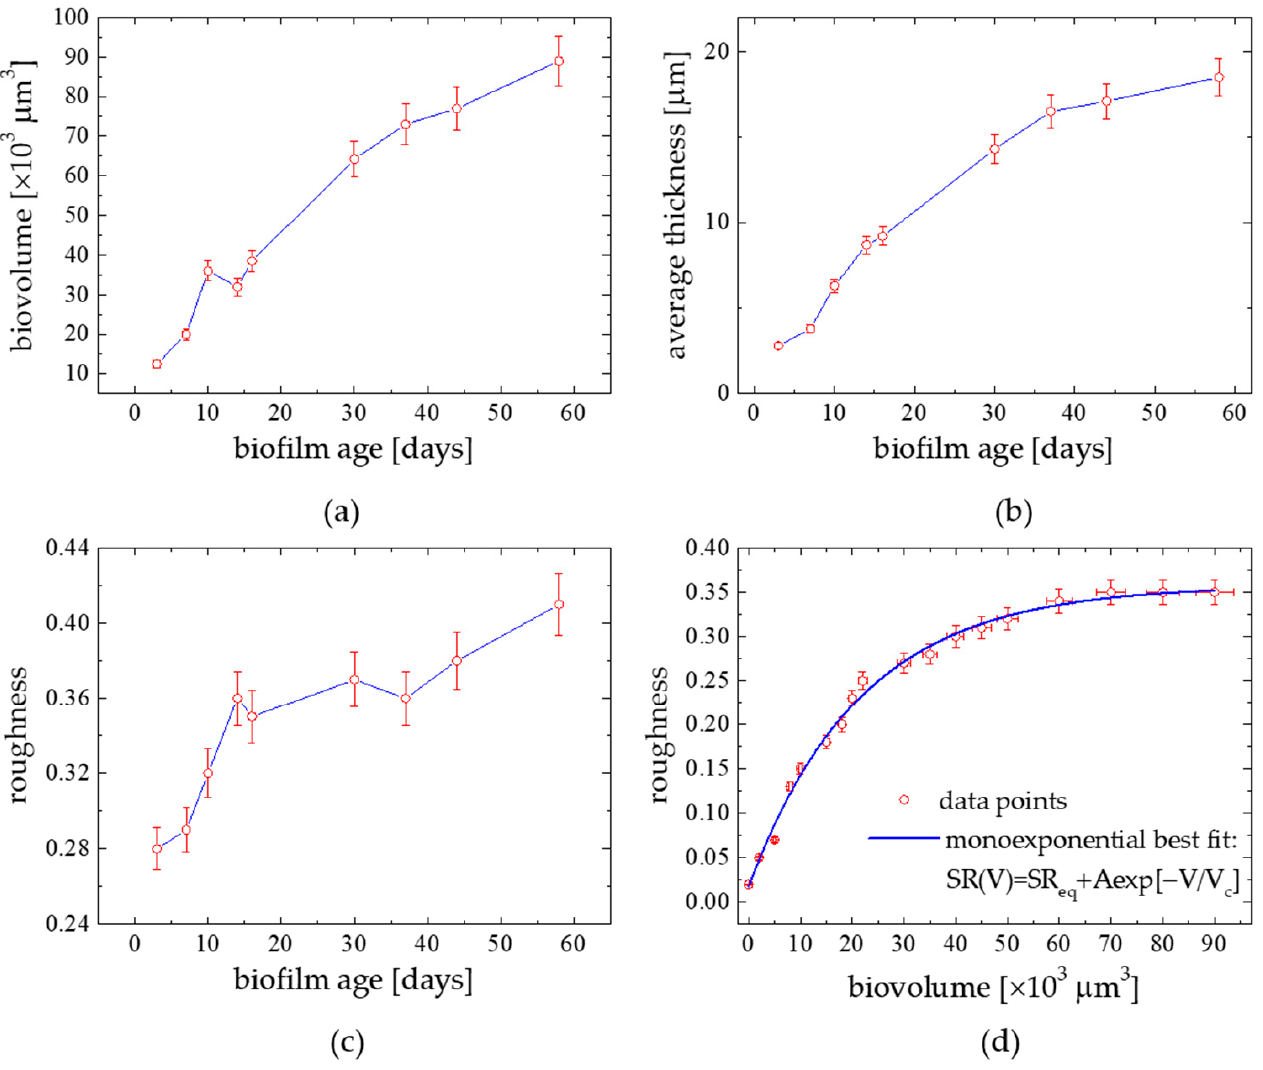
Figure 3. Structural parameters temporal development of a marine phototrophic biofilm grown on glass slides in natural seawater (Baltic Sea, Gulf of Gda´nsk, Poland in August–October 2018); ( a ) biovolume, ( b ) average thickness, ( c ) R rms roughness, and ( d ) correlation between biofilm roughness and biovolume; the line represents the monoexponential fit to the data (R = 0.99).